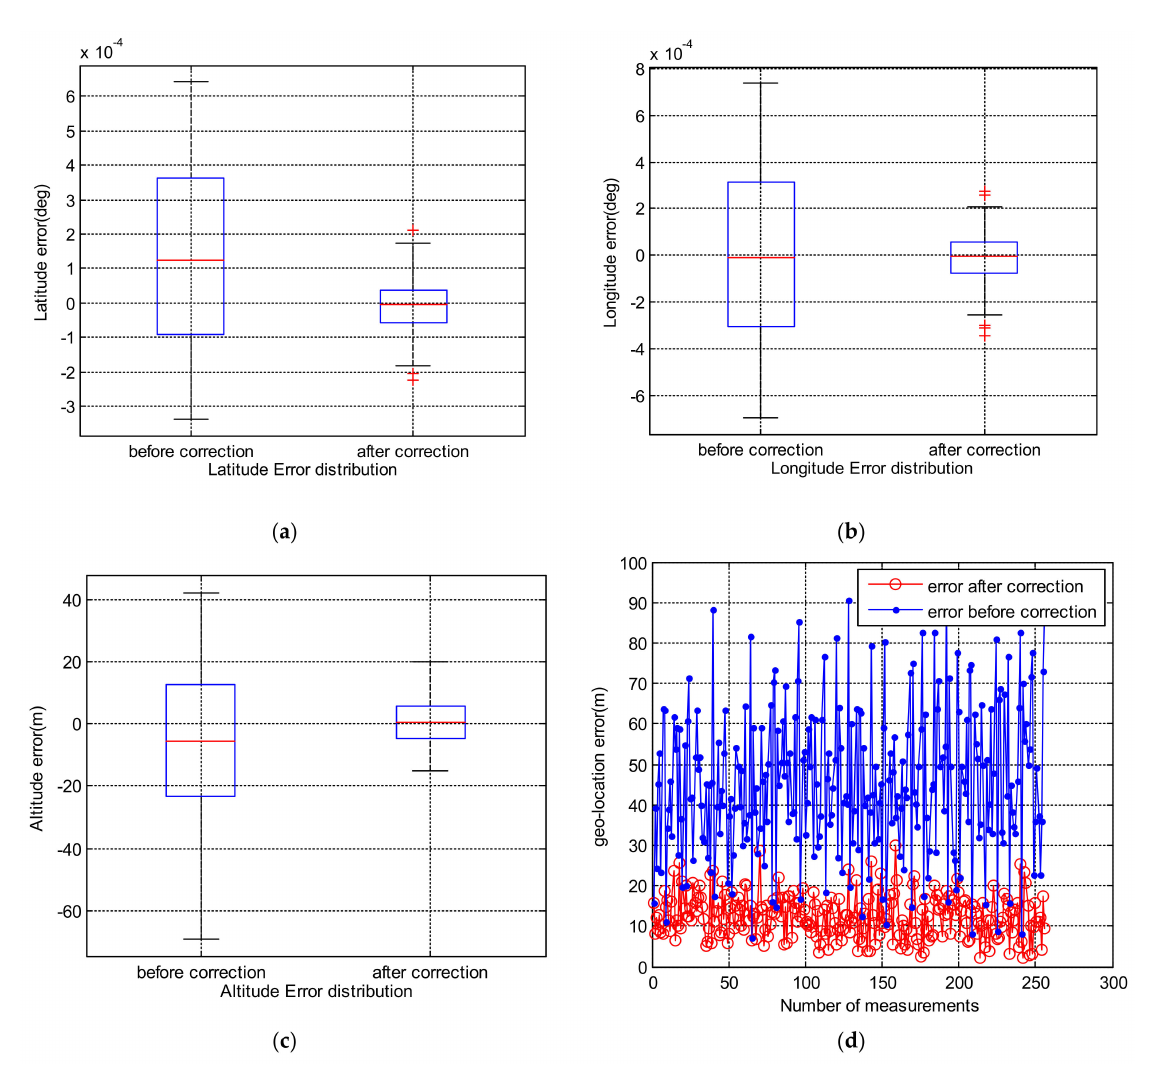
Figure 12. The computation results of the installing errors: ( a ) Box plot of latitude error of geo-location before and after correction; ( b ) Box plot of longitude error of geo-location before and after correction; ( c ) Box plot of altitude error of geo-location before and after correction; ( d ) Error of geo-location before and after correction. Table 6. The comparison of geo-location between before and after